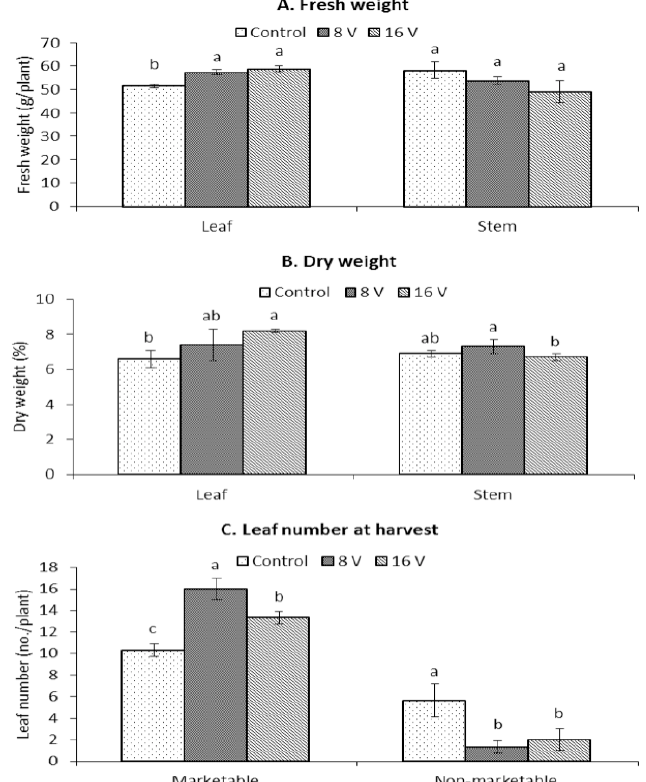
Fig. 4: Effect of different voltage applications on fresh (A) and dry (B) weight and marketable and non-marketable leaves (C) of African nightshade plants. Mean values (± standard deviation) within a spe - cific variable followed by the same letter are not significantly diffe - rent according to Tukey-test ( p < 0.05).